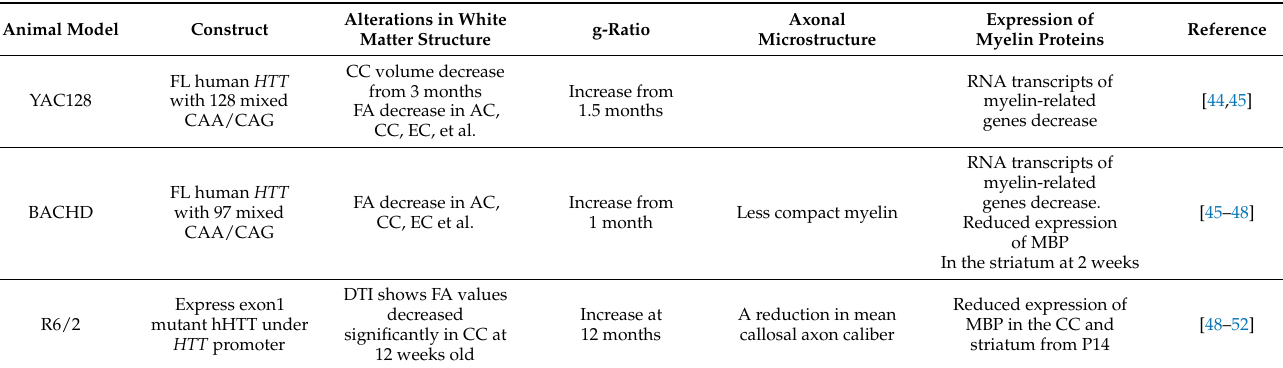
Table 1. HD mouse models used for myelin defect